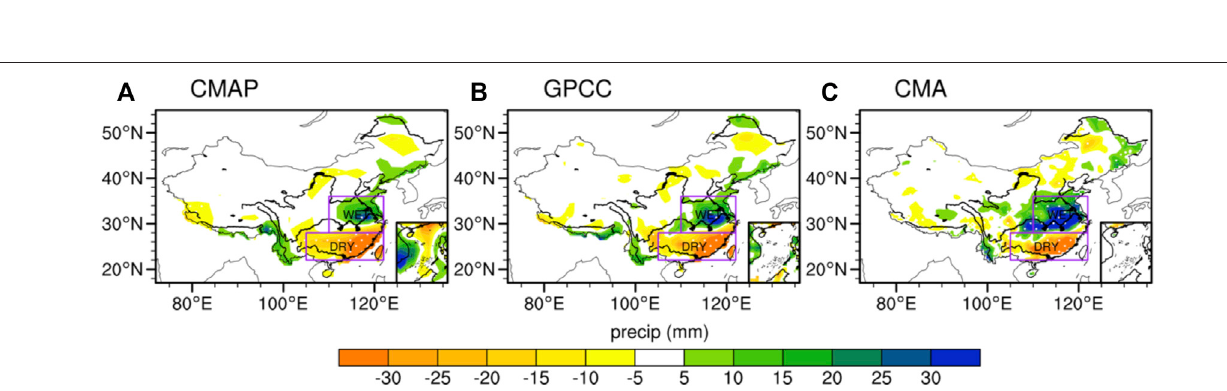
FIGURE5| EvolutionofregressedCMAPrainfallanomalies(units:mm)from (A – H) NovembertoJuneagainstthestandardizedNovember – DecembermeanArctic sea ice concentration in Barents – Kara Seas. The boxes marked arethe same asin Figures 2D – F . The dotted regions show the regression at the 95% con fi dence level.